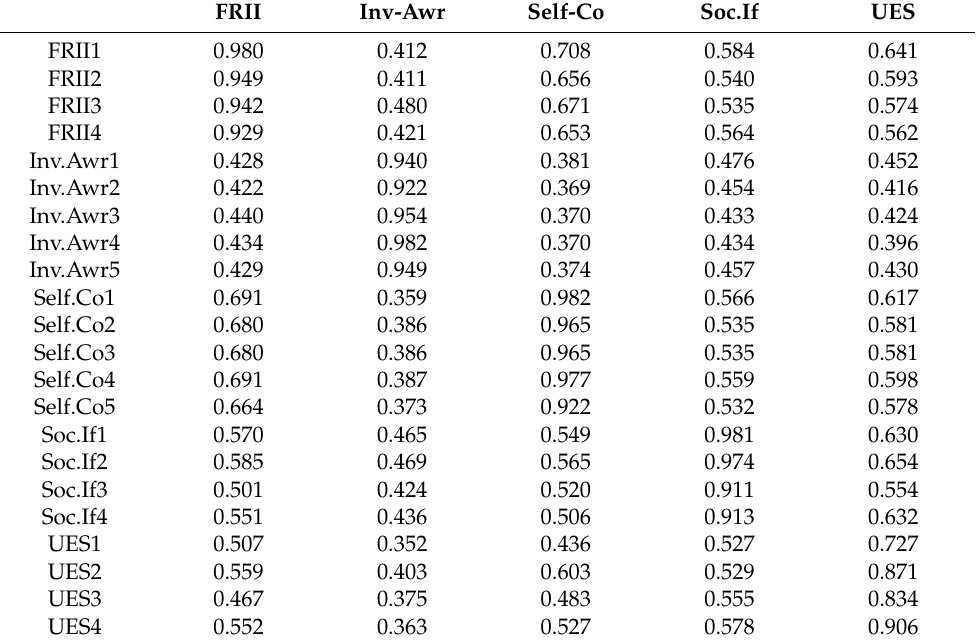
Table 2. Factor loading and cross-loadings.